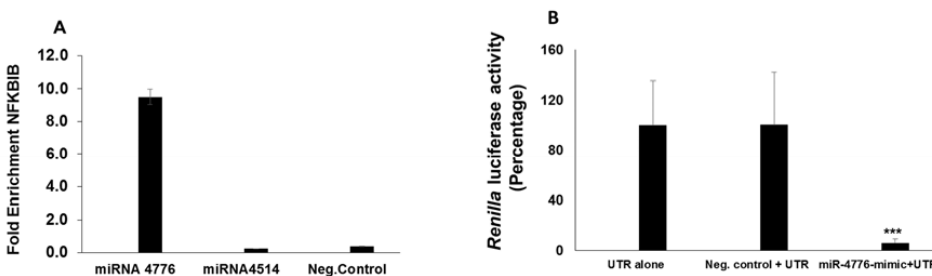
Figure 8. Confirmation of miR-4776 target by Argonaut Immunoprecipitation and luciferase 3’ UTR Figure 8 . Confirmation of miR ‐ 4776 target by Argonaut Immunoprecipitation and luciferase 3’ UTR assay. ( A ) HBEpCs were transfected with miR-4776 mimic, miR-4514 mimic or negative control assay. ( A ) HBEpCs were transfected with miR ‐ 4776 mimic, miR ‐ 4514 mimic or negative control mimic, and, after 24–36 h. the cells were collected and immunoprecipitated using the Ago or isotype antibody. RNA was isolated and the fold enrichment of NFKBIB transcript was